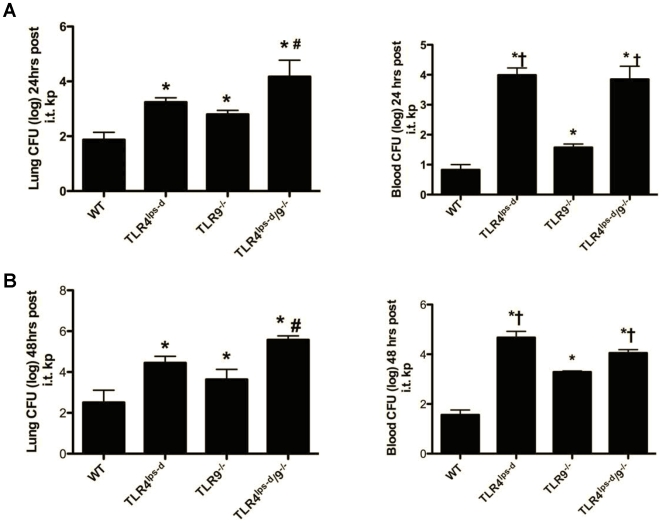
Lung and blood CFU from WT, TLR4lps-d, TLR9−/−, and TLR4lps-d/TLR9−/− mice 24 hrs and 48 hrs post i.t. Klebsiella challenge.Mice were given 5×102 CFU Klebsiella i.t., lungs and blood harvested at designated time points and CFU assessed. Panel A shows lung and blood CFU at 24 hrs and panel B is lung and blood CFU at 48 hrs post i.t. Klebsiella challenge. CFU are expressed in mean log10 ± SEM. n = 6−8, * p<0.05 as compared to WT mice, # p<0.01 as compared to single mutants, †<0.05 as compared to TLR9−/− mice.